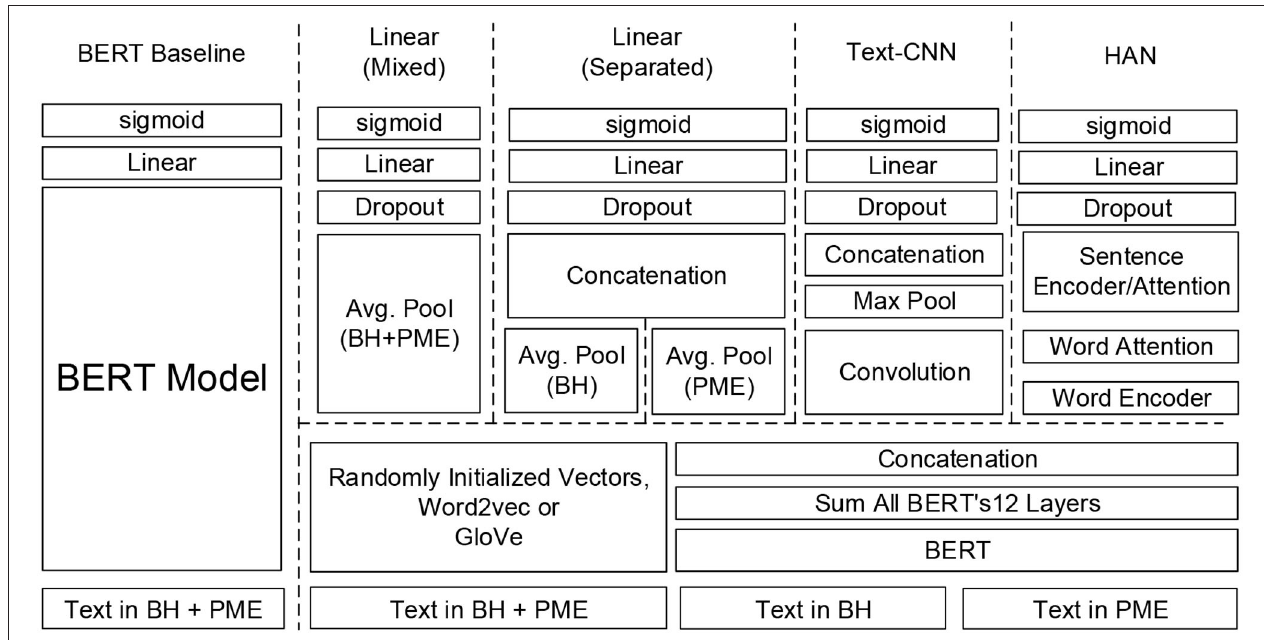
FIGURE 3 | Deep learning text classification models developed in this